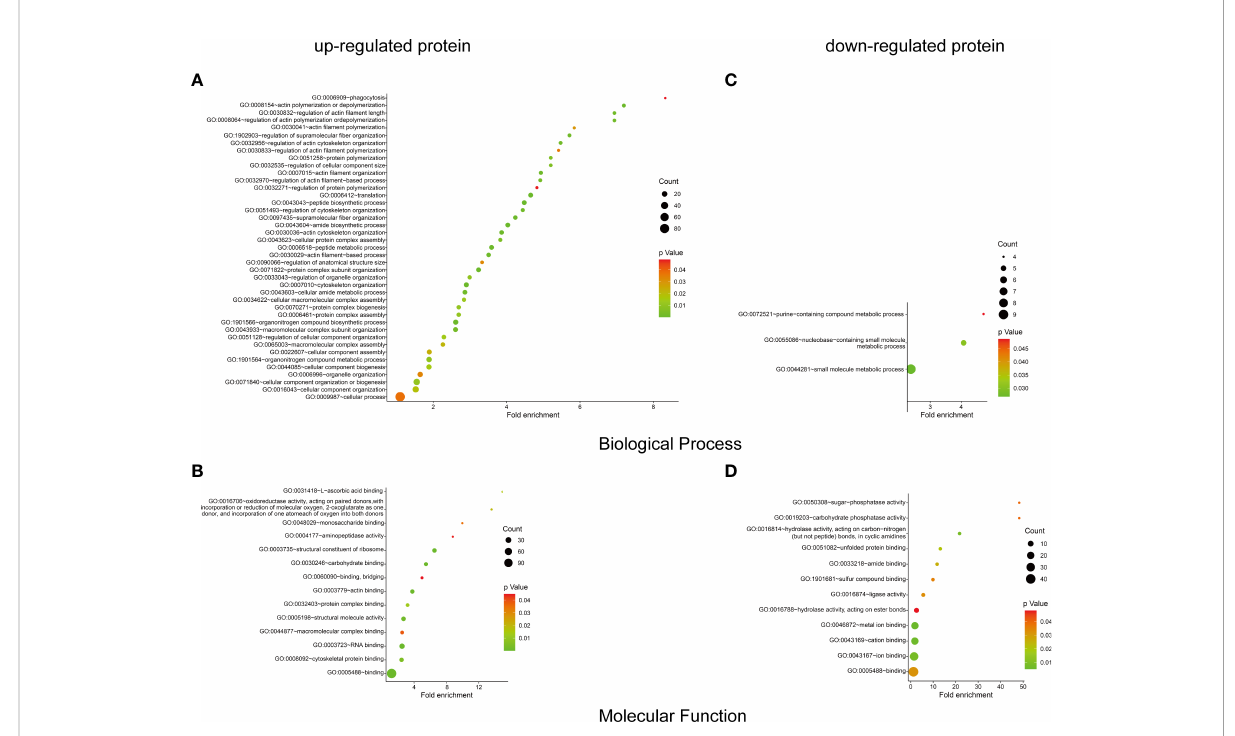
FIGURE 3 GO enrichment analysis of the differential proteins. The biological process and molecular function terms enrichment results of up-proteins (A, B) and down-regulated proteins (C, D) were conducted by DAVID. More information is available in Supplementary Table 1. The fi gure was created with ImageGP